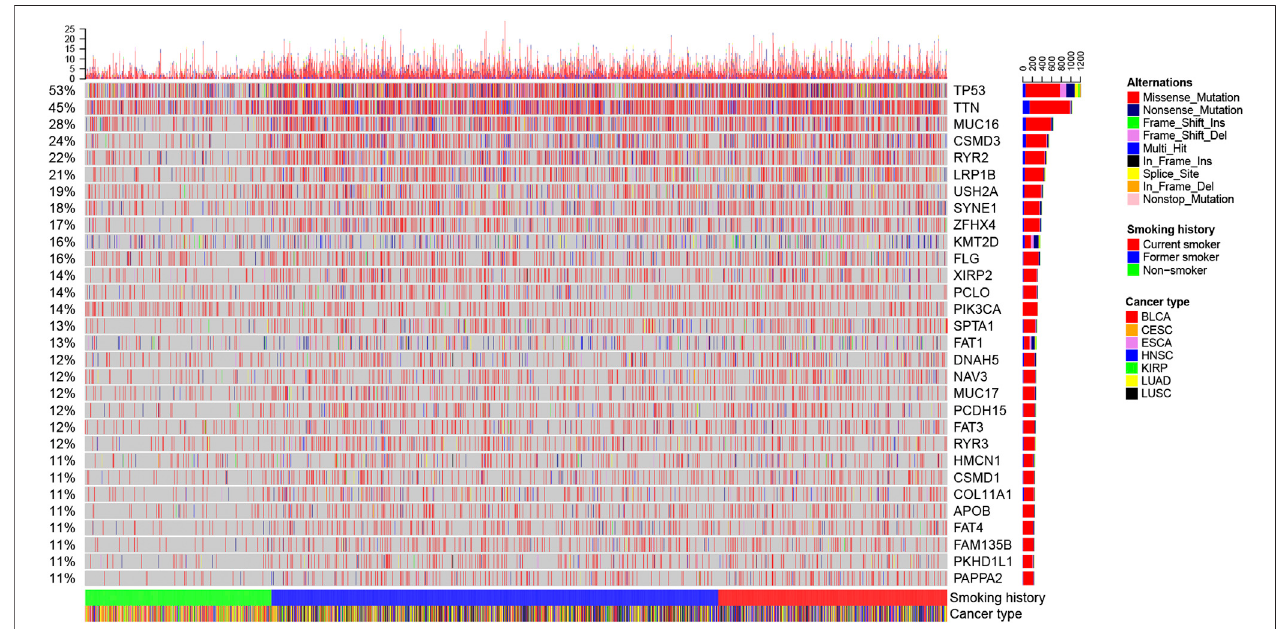
FIGURE 5 | Landscape of the top 30 genes with higher SNV incidence in patients with different smoking histories.